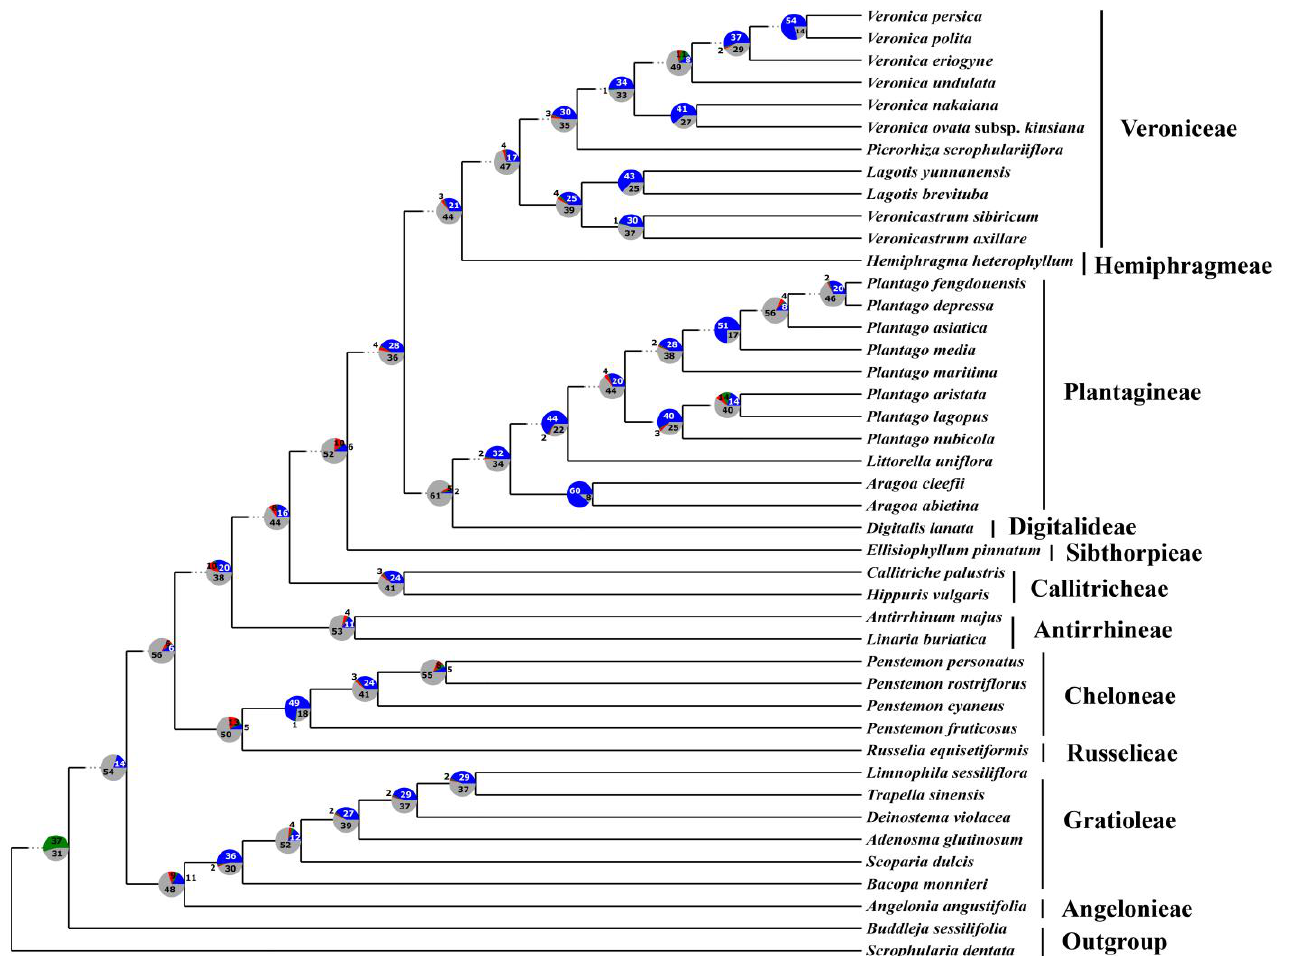
Figure 6. Summary of gene-tree concordance and conflict based on the PhyParts analysis of the 68 plastid gene trees mapped against the species tree (ASTRAL). The pie charts show the proportion and the numbers of genes in concordance (blue), conflict (green = a single dominant alternative; red = all other conflicting trees), and without information (grey) at each node in the species tree.